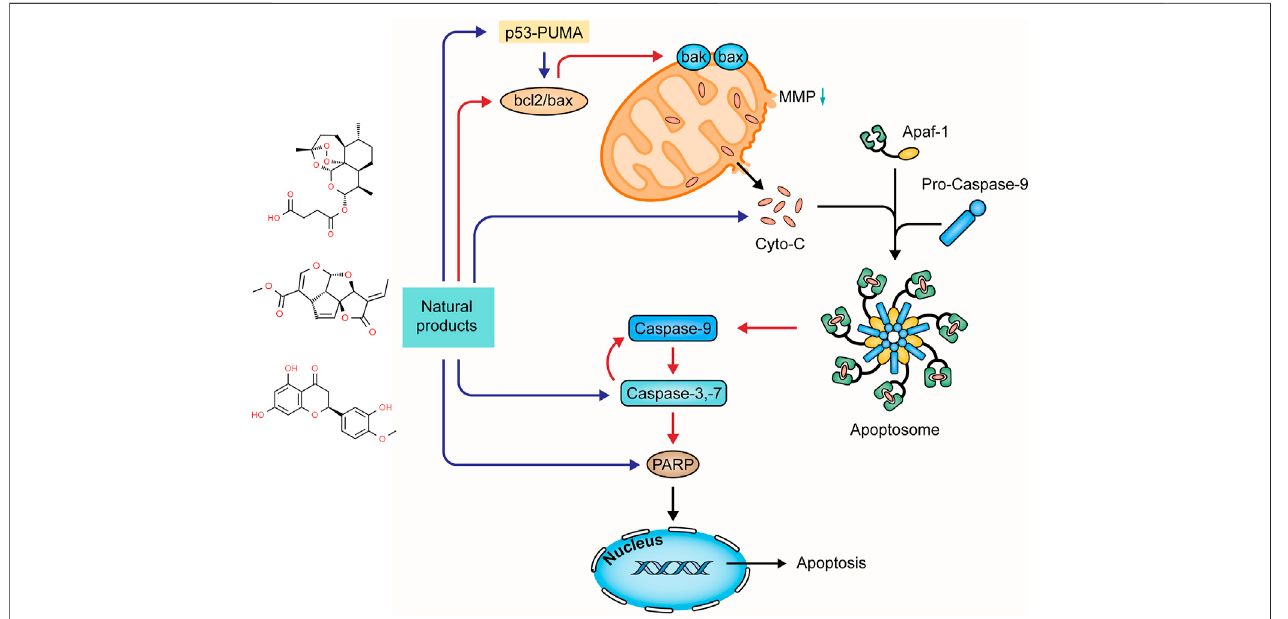
FIGURE 2 | Natural products modulate apoptosis of IECs through mitochondria-dependent pathway.